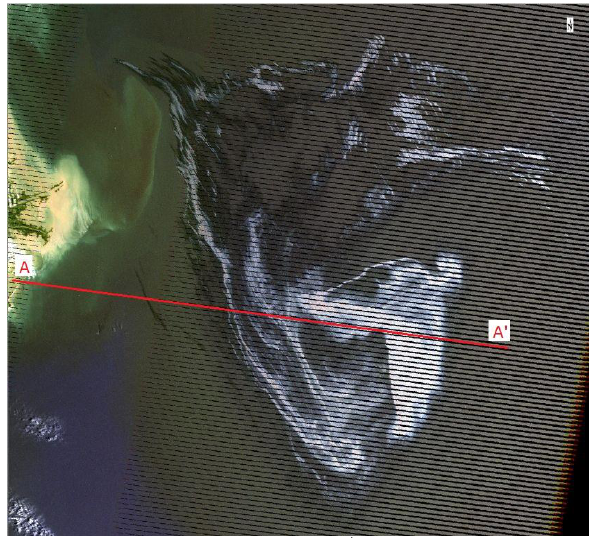
Figure 4a. Deep Water Horizon, 1 st May 2010, true colour LANDSAT7 image. The width of the image is about 90 km. Figure 4b and 4c show the amplitudes for the true colours